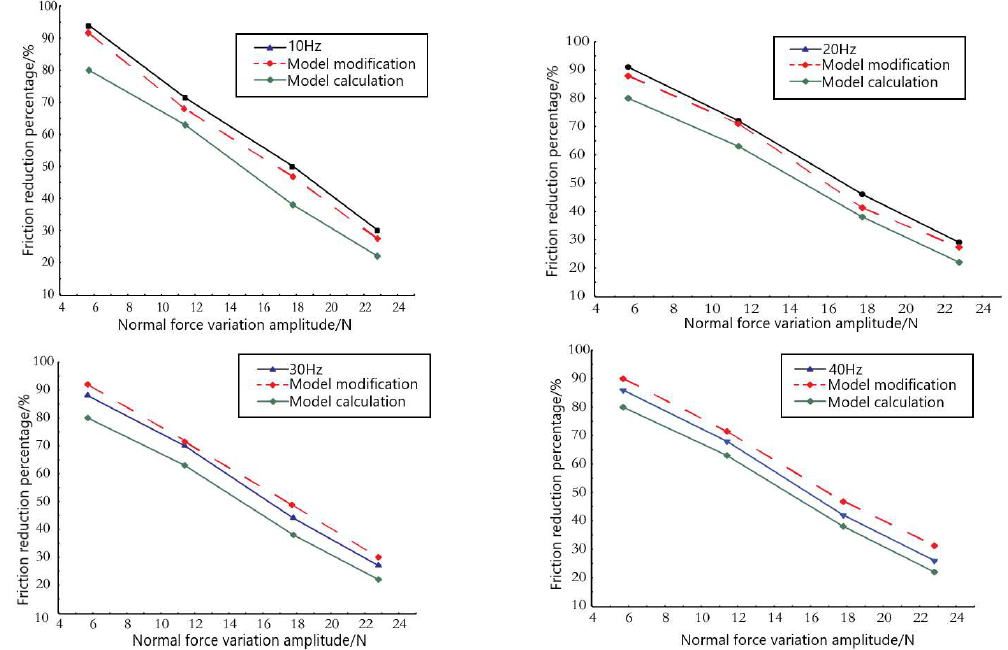
Figure 9. Comparison of modified model results and experimental results.